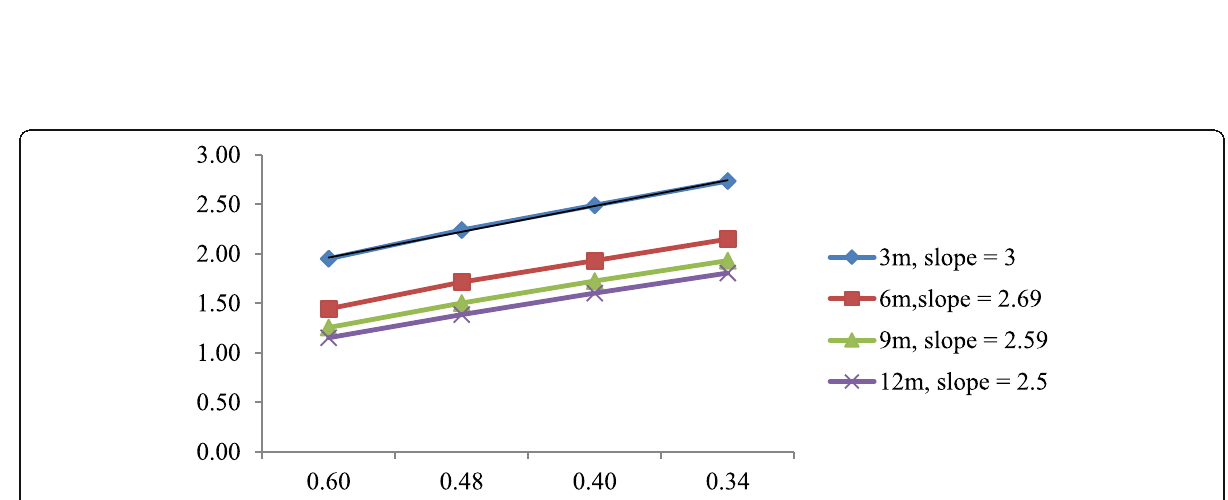
Fig. 12 Slope angle decrease versus FoS for different slope heights